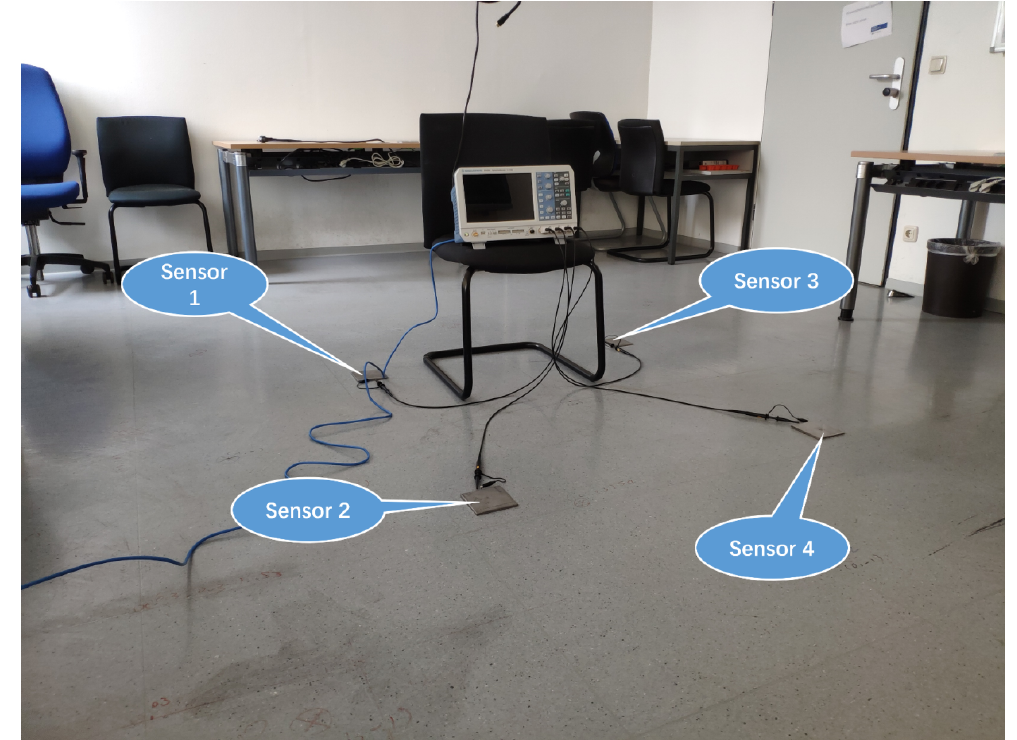
Figure 6. Data acquisition devices and experiment